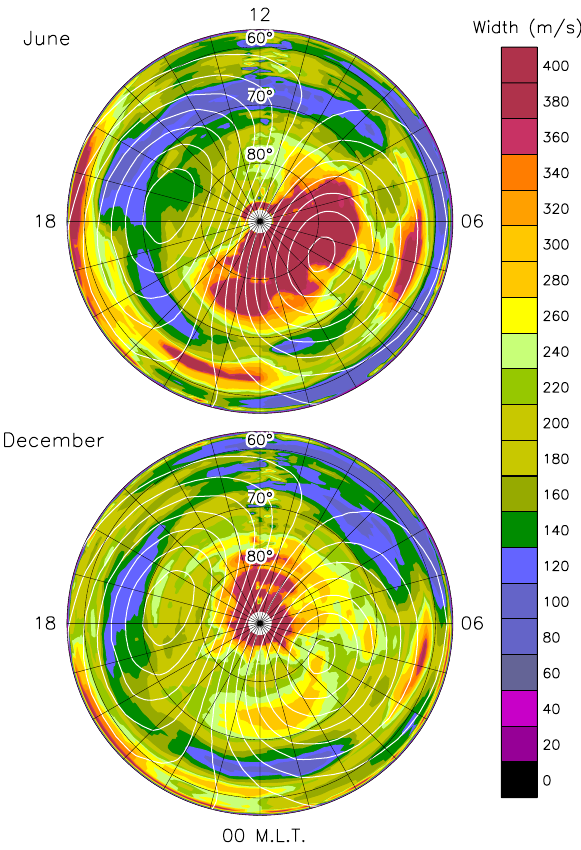
Fig. 11. Average Doppler spectral widths recorded on beam 4 and for all K p values during 30-day intervals centred on (a) June (win- ter) solstice and (b) December (summer) solstice for the years 2000 to 2003. The results have been smoothed with a median filter of width 5 to emphasise persistent large-scale variations. Similar to Fig. 1, equipotentials given by the DICM have been superimposed